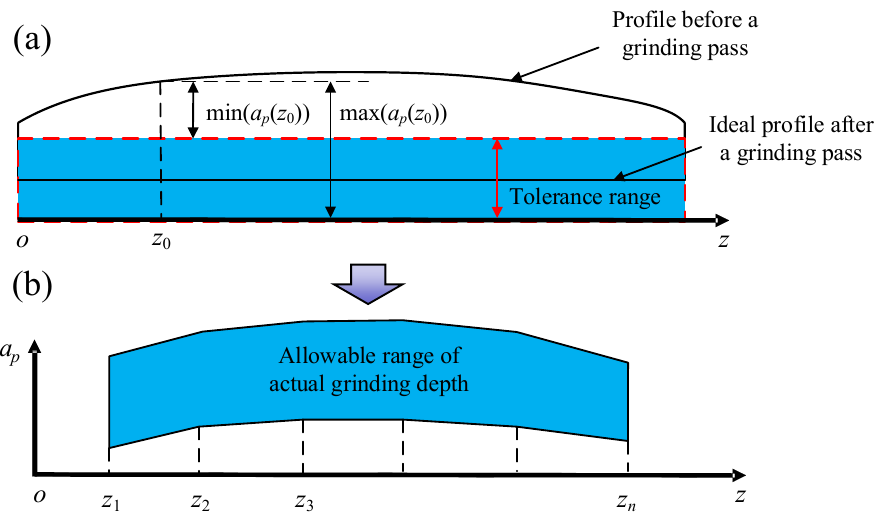
Figure 9. The principle of the adjustment of actual grinding depth: ( a ) the profile of the shaft before a grinding pass and the ideal profile after a grinding pass, ( b ) the allowable range of the actual grinding depth.